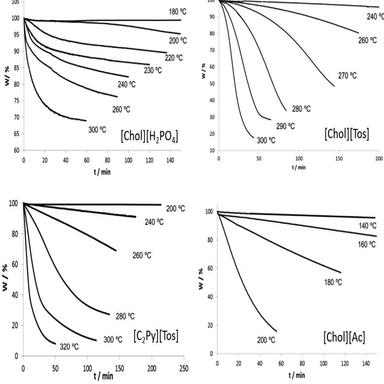
Isothermal scans in air atmosphere at different temperatures for the four ILs. All experiments were performed at atmospheric pressure of 998 ± 12 hPa.